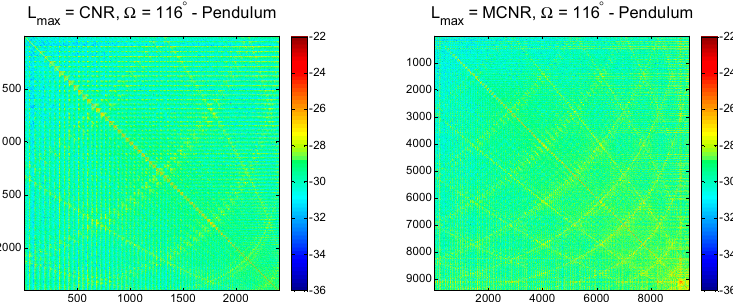
Figure 17. Covariance matrices of 6-day solutions of the scenario (a) Pendulum formation for Ω = 116°. Top left : L max = 32, top right : L max = 64, bottom left : L max = CNR, and bottom right : L max = MCNR.